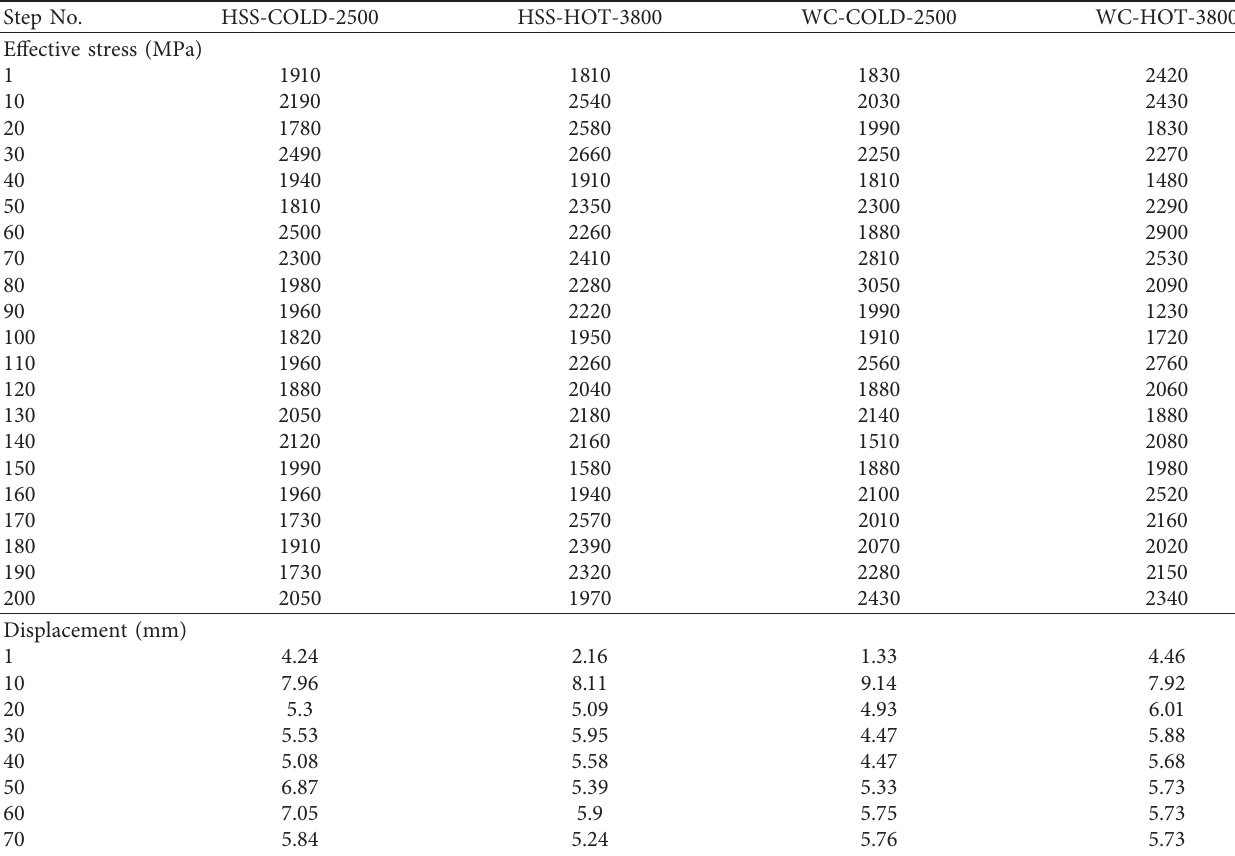
Figure 7: ANN hidden layer and output layer structure used for modeling. Table 7: Deform 3D simulation values of effective stress (von Mises) and